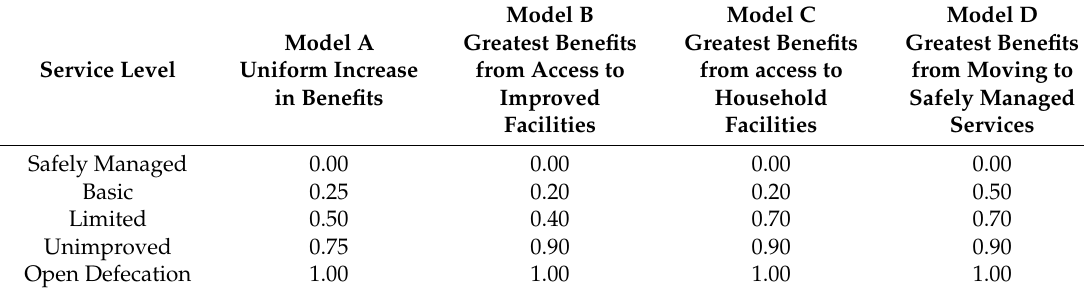
Table 1. Service level weights for four ‘total service gap’ models.